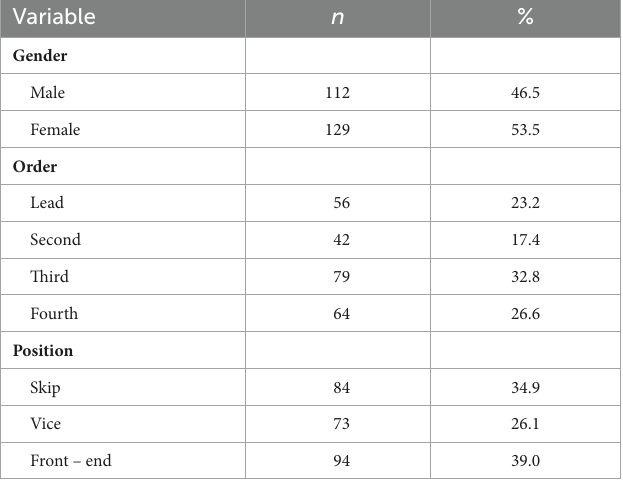
TABLE 1 Descriptive of the